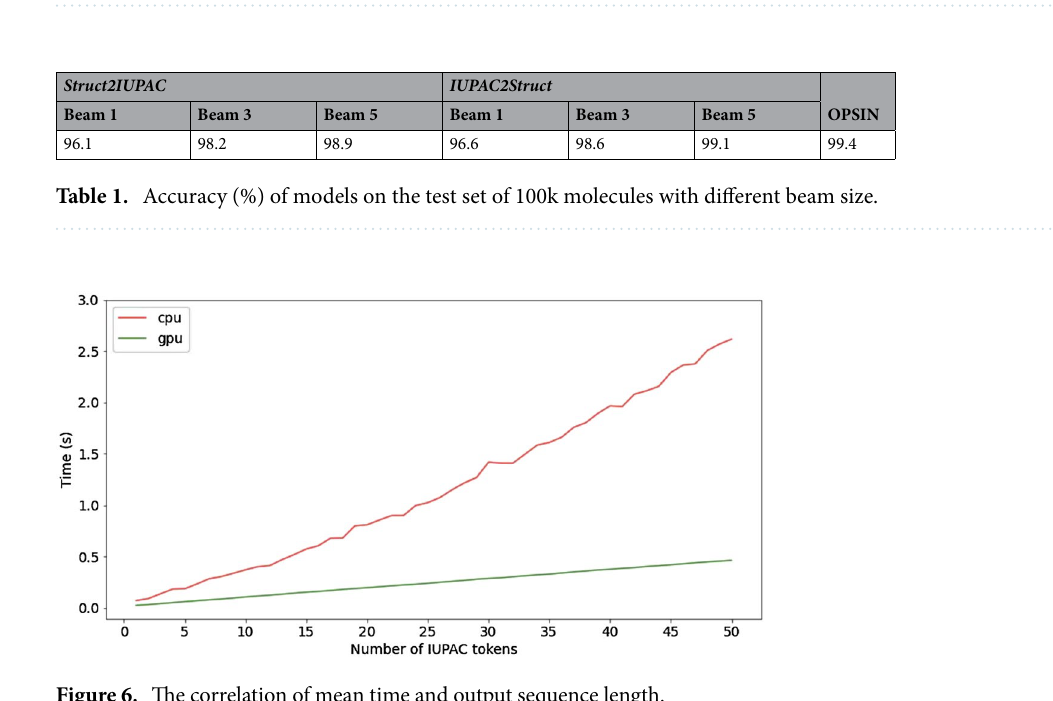
Figure 5. The distribution of the lengths of SMILES and IUPAC on the test set.